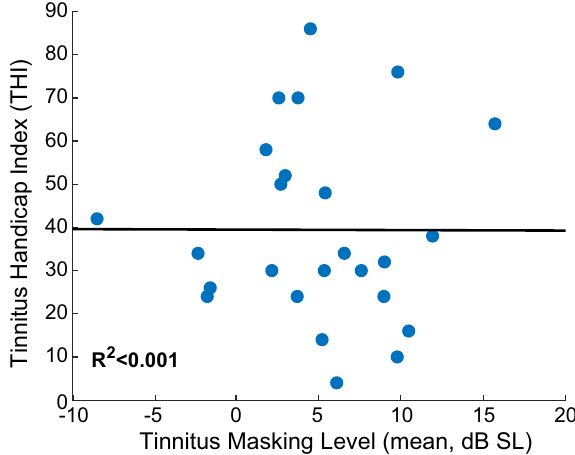
Fig. 6 Tinnitus handicap index (THI) score versus minimum masking level (MML). Minimal correlation is observed between a patients reported tinnitus severity and the sound level required to mask their